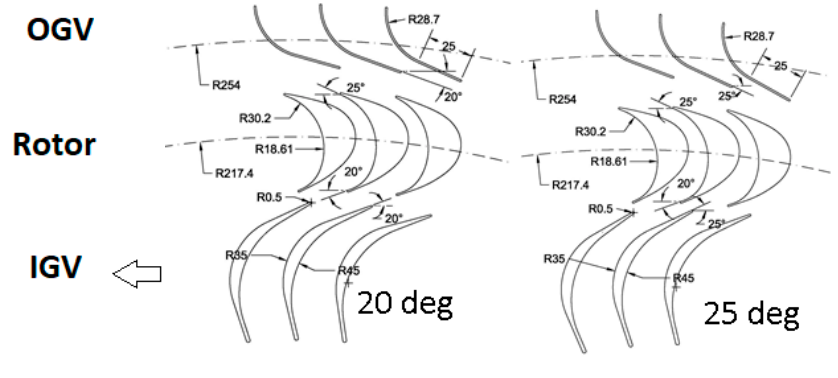
Figure 4 . M16 Geometry 20°/25°.